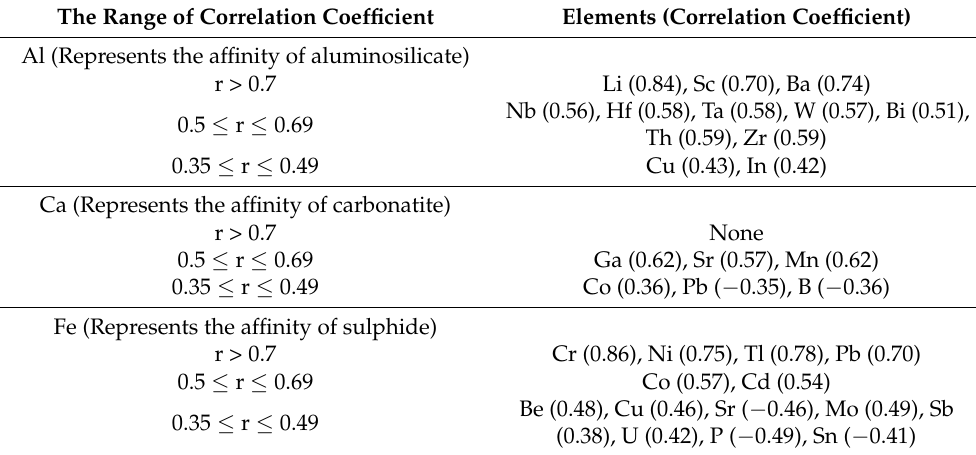
Table 8. The correlation coefficient distribution of major elements and trace